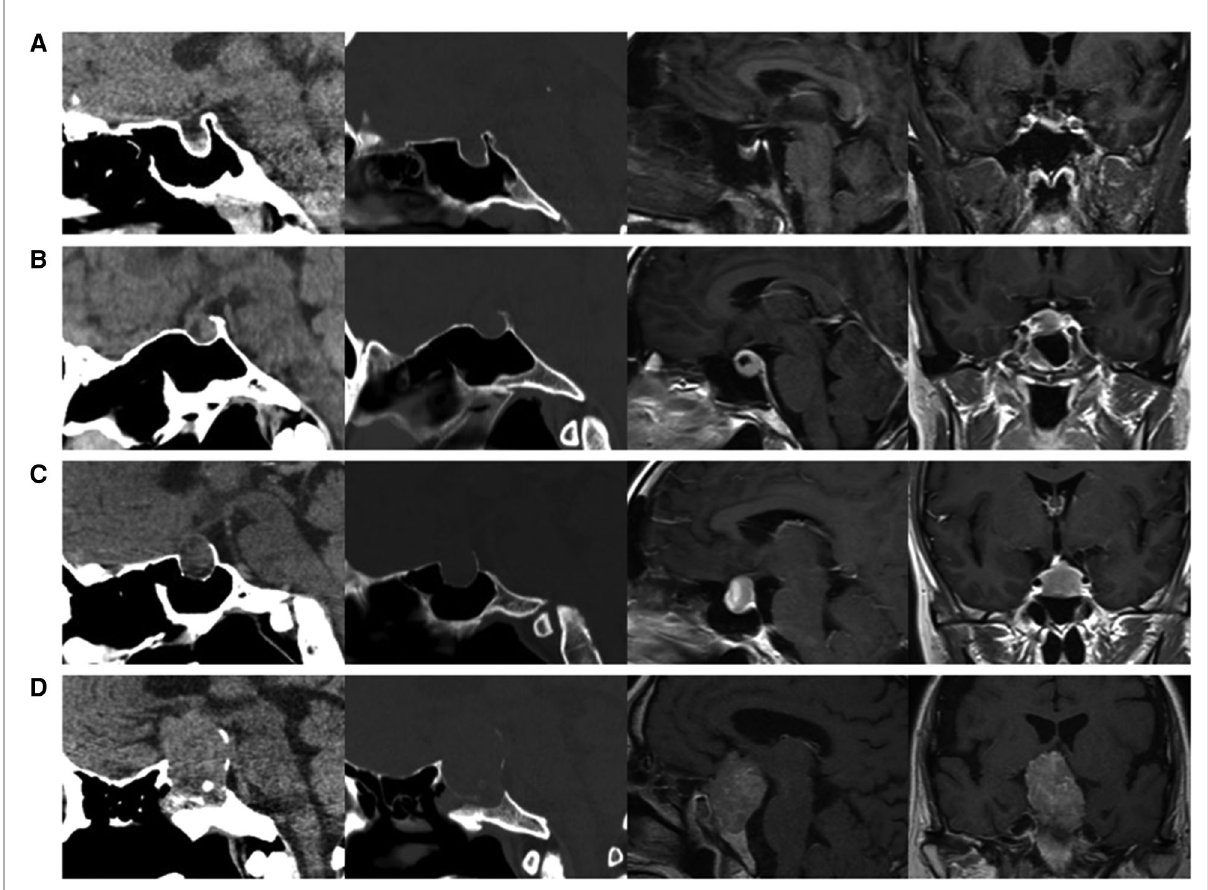
FIGURE 3 Sellar fl oor erosion grades of patients. ( A ) Grade I, sella normal or focally expanded; tumor <10 mm. ( B ) Grade II, sella enlarged; tumor ≥ 10 mm. ( C ) Grade III, localized sellar perforation. ( D ) Grade IV, diffuse destruction of the sellar fl